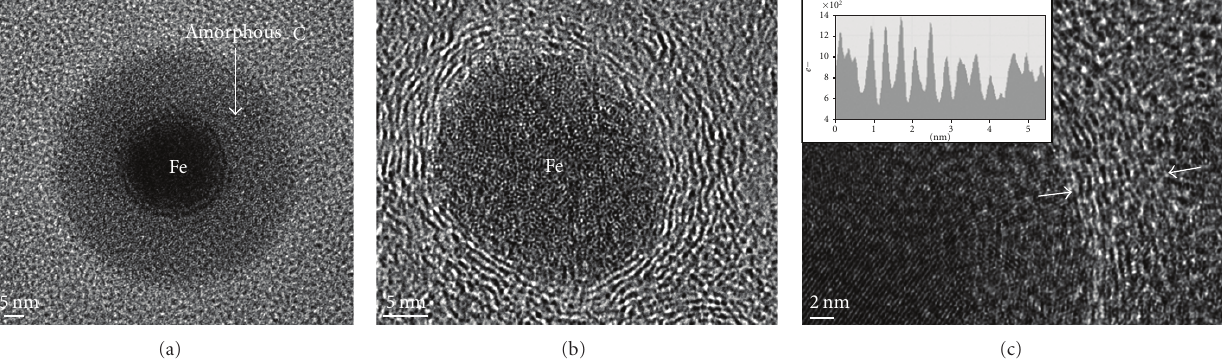
Figure 2: TEM of (a) as-produced core-shell nanoparticle ( I ), (b) an ester functionalized nanoparticle ( III ) (c), and The graphitic layer of III . Inset: interlayer spacing along the line between the arrows.